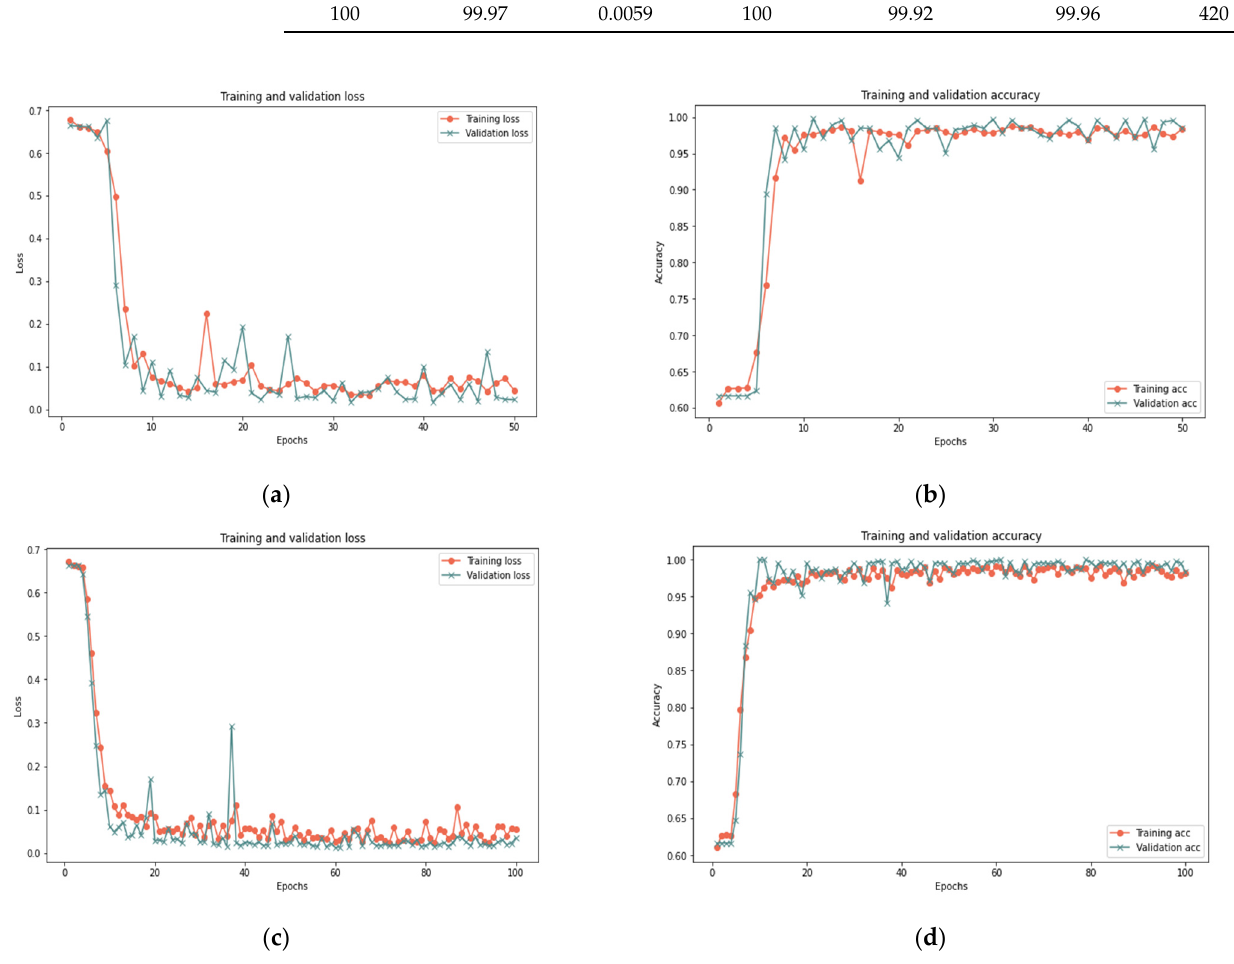
Figure 9. Results of the 25% sample size: ( a ) loss of 50 iterations, ( b ) accuracy of 50 iterations, ( c ) loss of 100 iterations, ( d ) accuracy of 100 iterations.